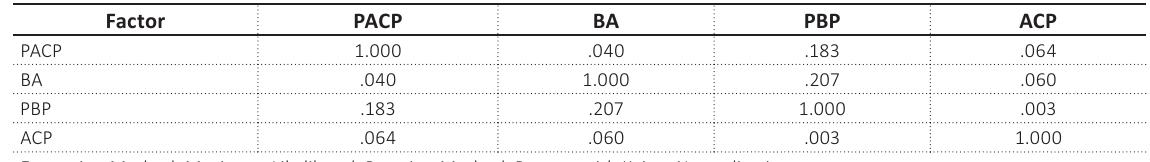
Table 1. Correlation analysis